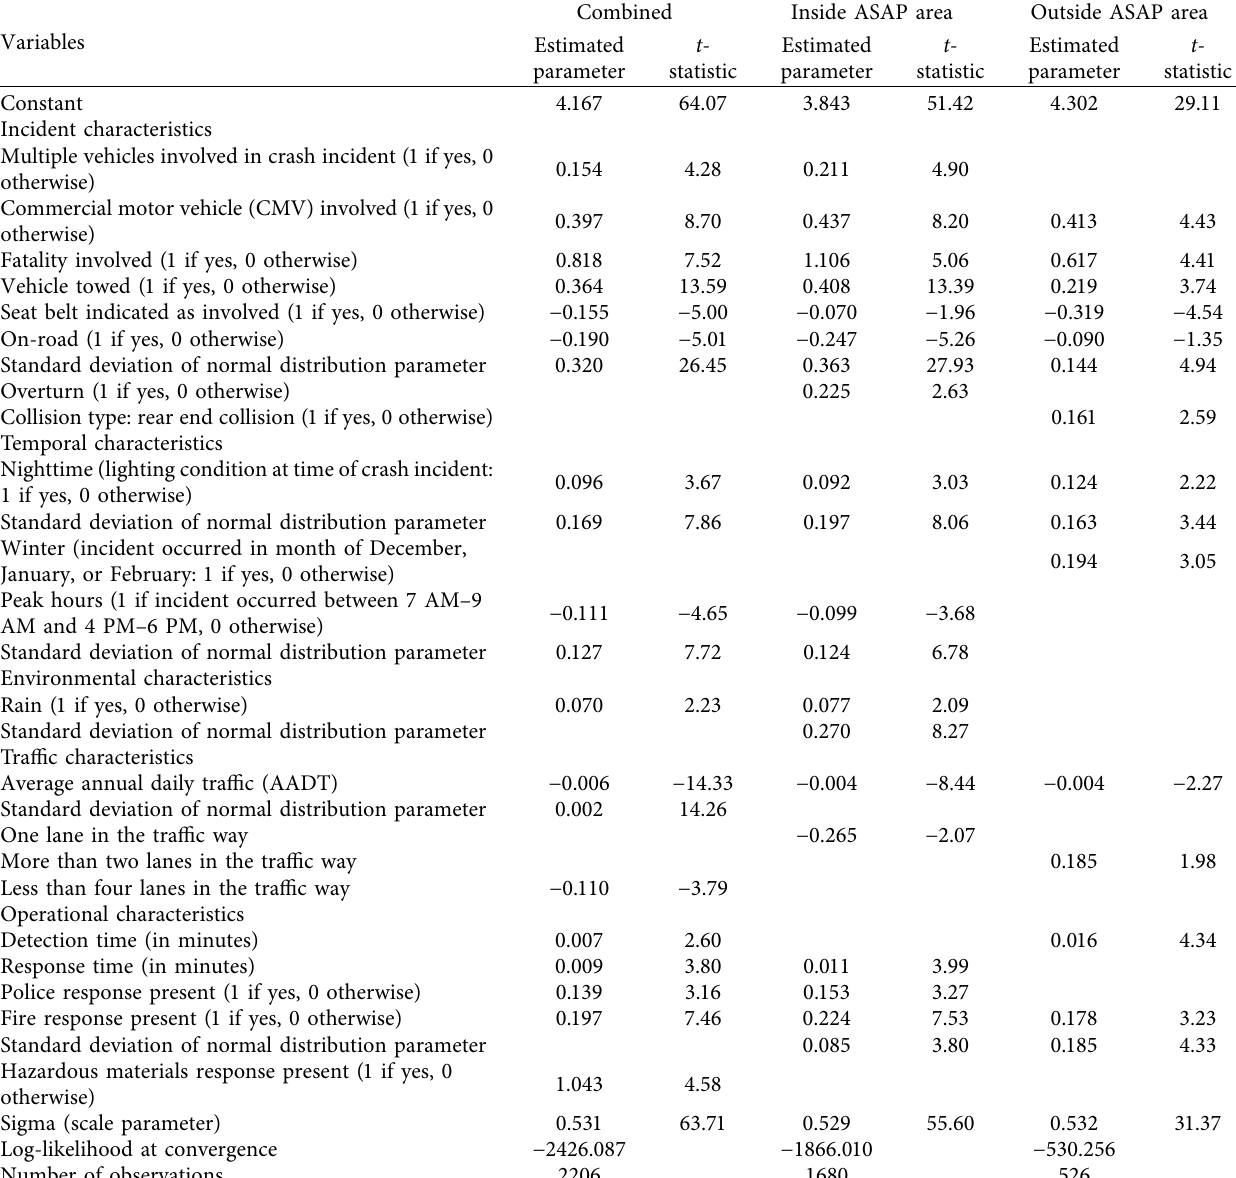
Table 2: Random parameters hazard-based duration model